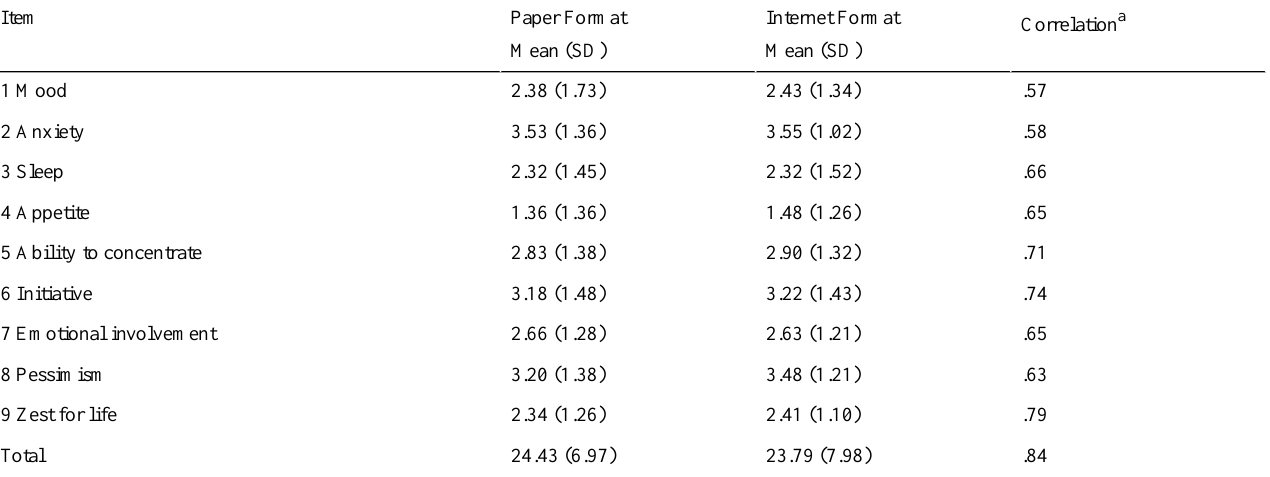
Table 3. MADRS-S item, mean score on paper and Internet and the correlation (Pearson) between